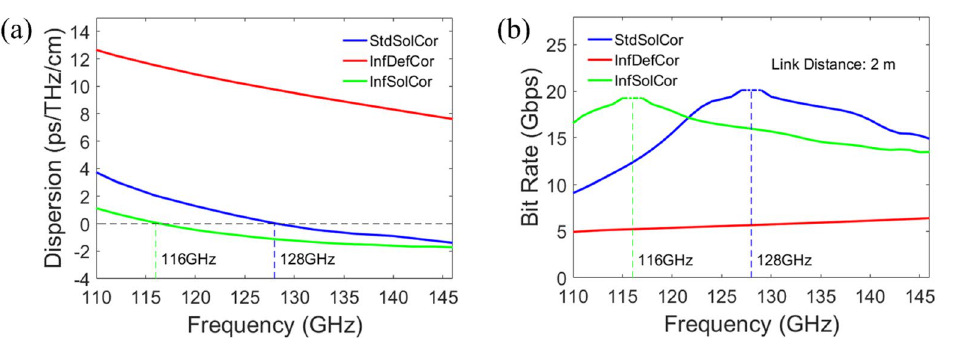
Figure 4. ( a ) Excitation efficiencies for the X-polarized and X-like modes for StdSolCor (top), InfDefCor (middle), and InfSolCor (bottom) as a function of the center position of the WR-6 waveguide flange at 128 GHz. WR-6 mode is X-polarized. Shown excitation efficiencies are optimized with respect to the fiber rotations. The white solid lines are fiber boundaries. ( b ) Excitation efficiencies of the two lowest order modes of the three fibers versus frequency for optimized coupling arrangement. Coupling is optimized for X-polarized or X-like modes at the carrier frequency of 128 GHz. Both fiber rotation and fiber position are optimized relative to a fixed WR-6 waveguide flange; Normalized electric field distributions and electric field directions (red arrows) for ( c ) the X-polarized mode of the WR-6 waveguide flange at 128 GHz and ( d ) the X-polarized or X-like modes of the three fibers at 128 GHz. White rectangles show optimized positions of the WR-6 waveguide.